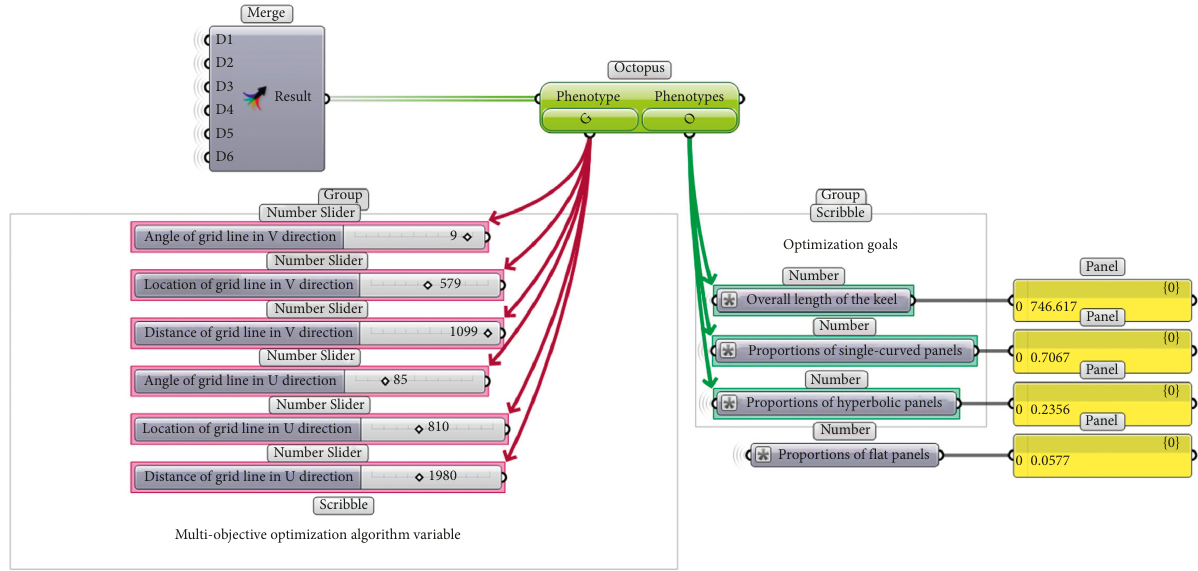
Figure 8: External connection of “ Octopus ” component.